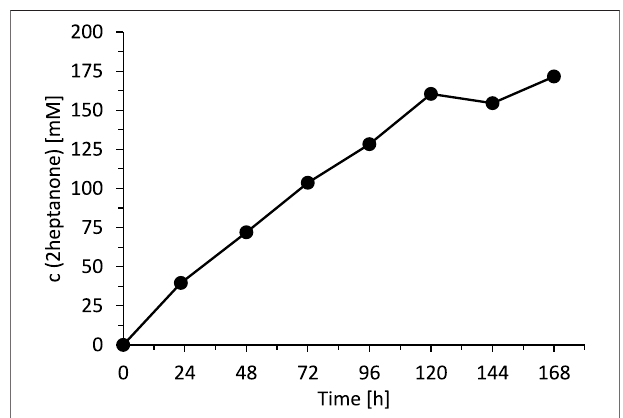
FIGURE 9 | Fed-batch transformation of rac -heptan-2-ol. Reaction conditions:[ rac -heptan-2-ol] org =[ethylacetoacetate] org :added(50 mMeach) at t = 0, 22.5, 48, 72, 96 and 120 h, [NADP + ] aq = 1 mM, [ E. coli C43(DE3) pET24b- syadh ]